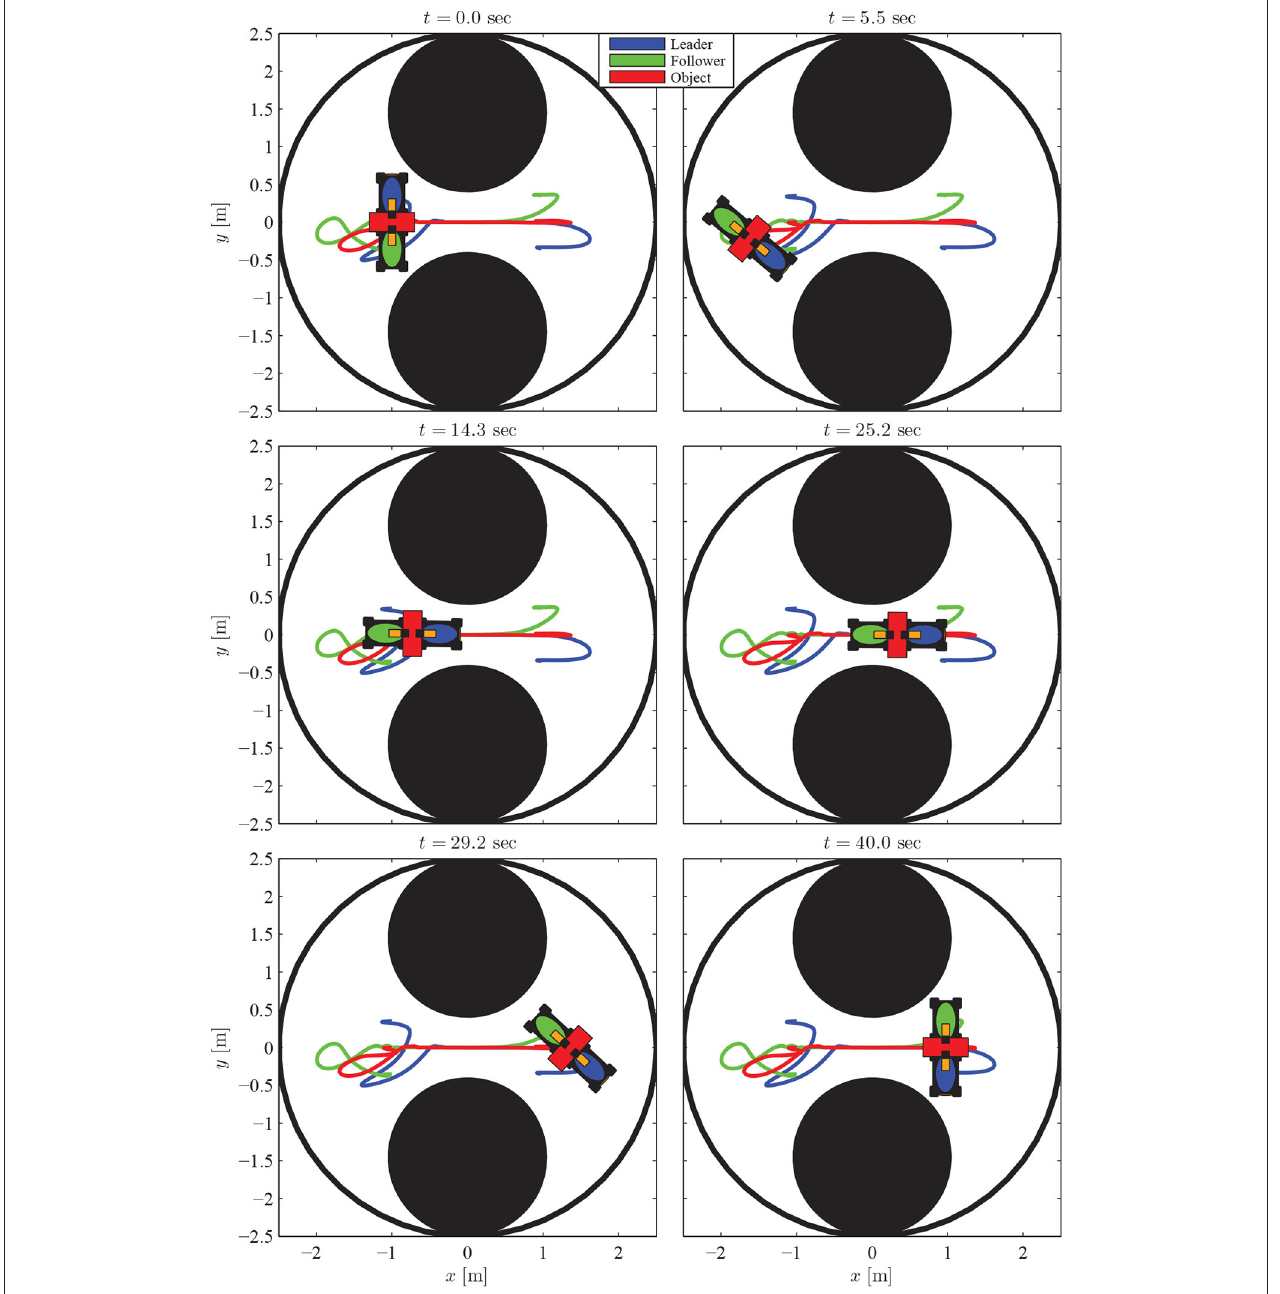
FIGURE 11 | The evolution of the proposed methodology in six consecutive time